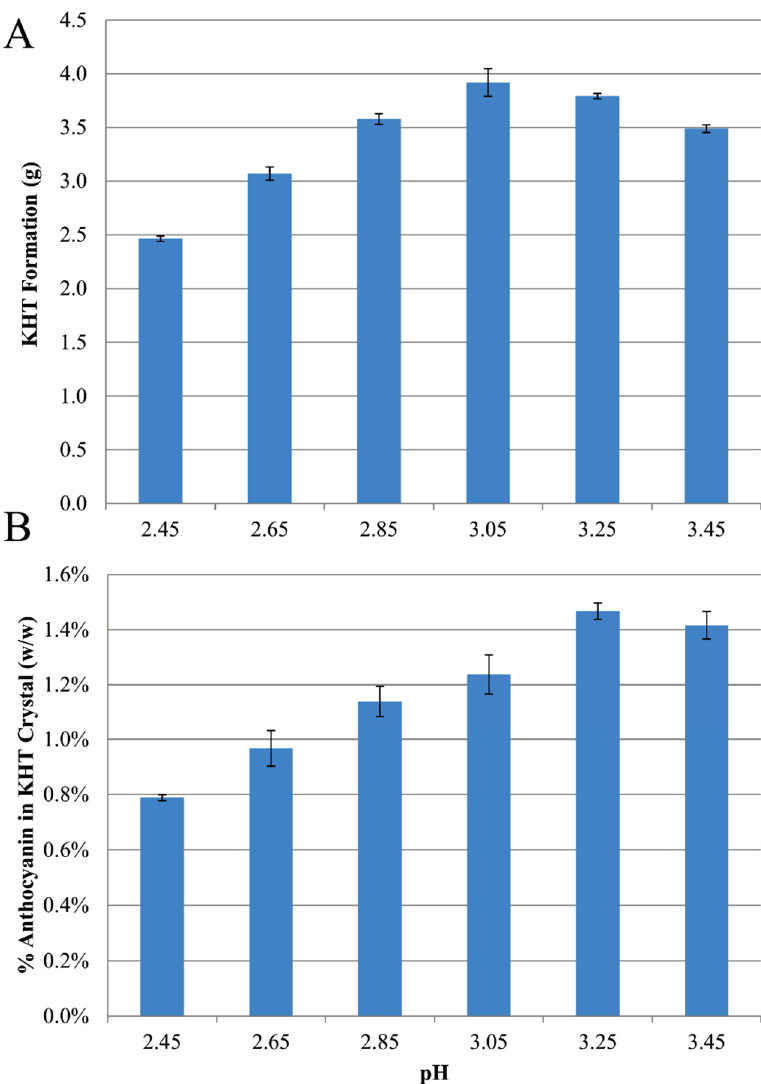
Figure 4. Effects of pH on ( A ) mass (g) of KHT crystals recovered by filtration after cold stabilization of Concord juices, and ( B ) total anthocyanin content (% w/w) of KHT crystals recovered from cold stabilized Concord